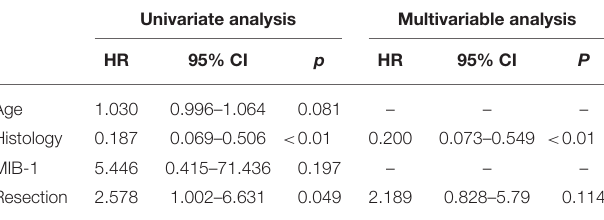
TABLE 3 | Overall survival.